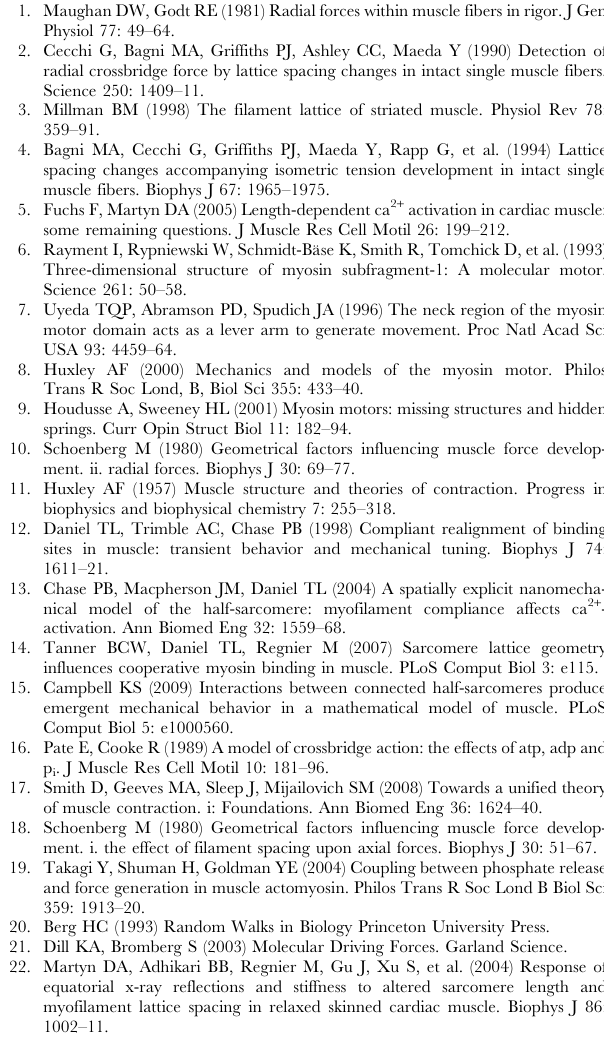
Figure S1 Model simulation protocol. The model simulation process, as described throughout the paper, is displayed as a state diagram. Entering the diagram at ‘‘Start’’, the states and actions which change those states are depicted for a single cross-bridge. Found at: doi:10.1371/journal.pcbi.1001018.s001 (0.06 MB PDF)